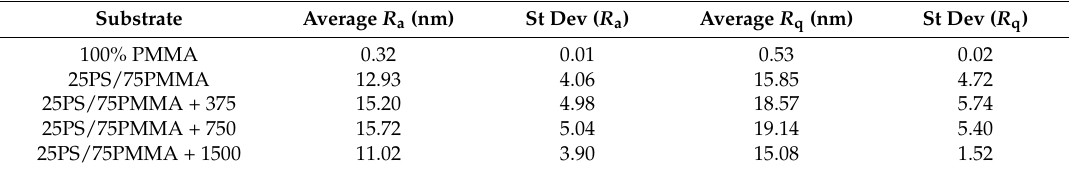
Table 2. Mean ( n = 3) surface roughness ( R a ) and root mean square roughness ( R q ) values calculated from AFM images acquired for 25PS/75PMMA demixed spin coated surfaces with and without addition of 375, 750 and 1500 50 µ m PS microspheres per mL. Data for a spin coated 100% PMMA film is included for